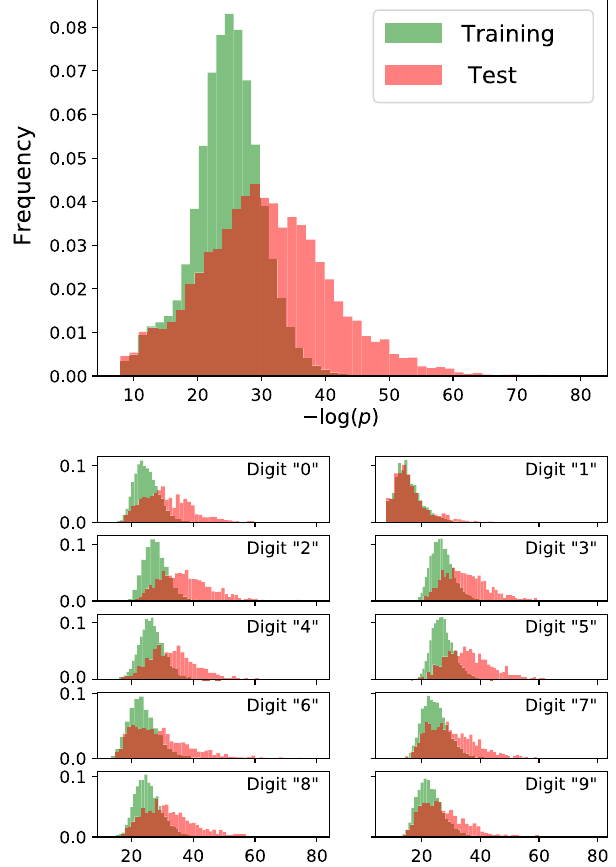
FIG. 8. Top: Distribution of − ln p of 60 000 training images and 10 000 test images given by a trained MPS with D The training negative log likelihood L L 30 . 3 . Bottom: Distributions for each test ¼